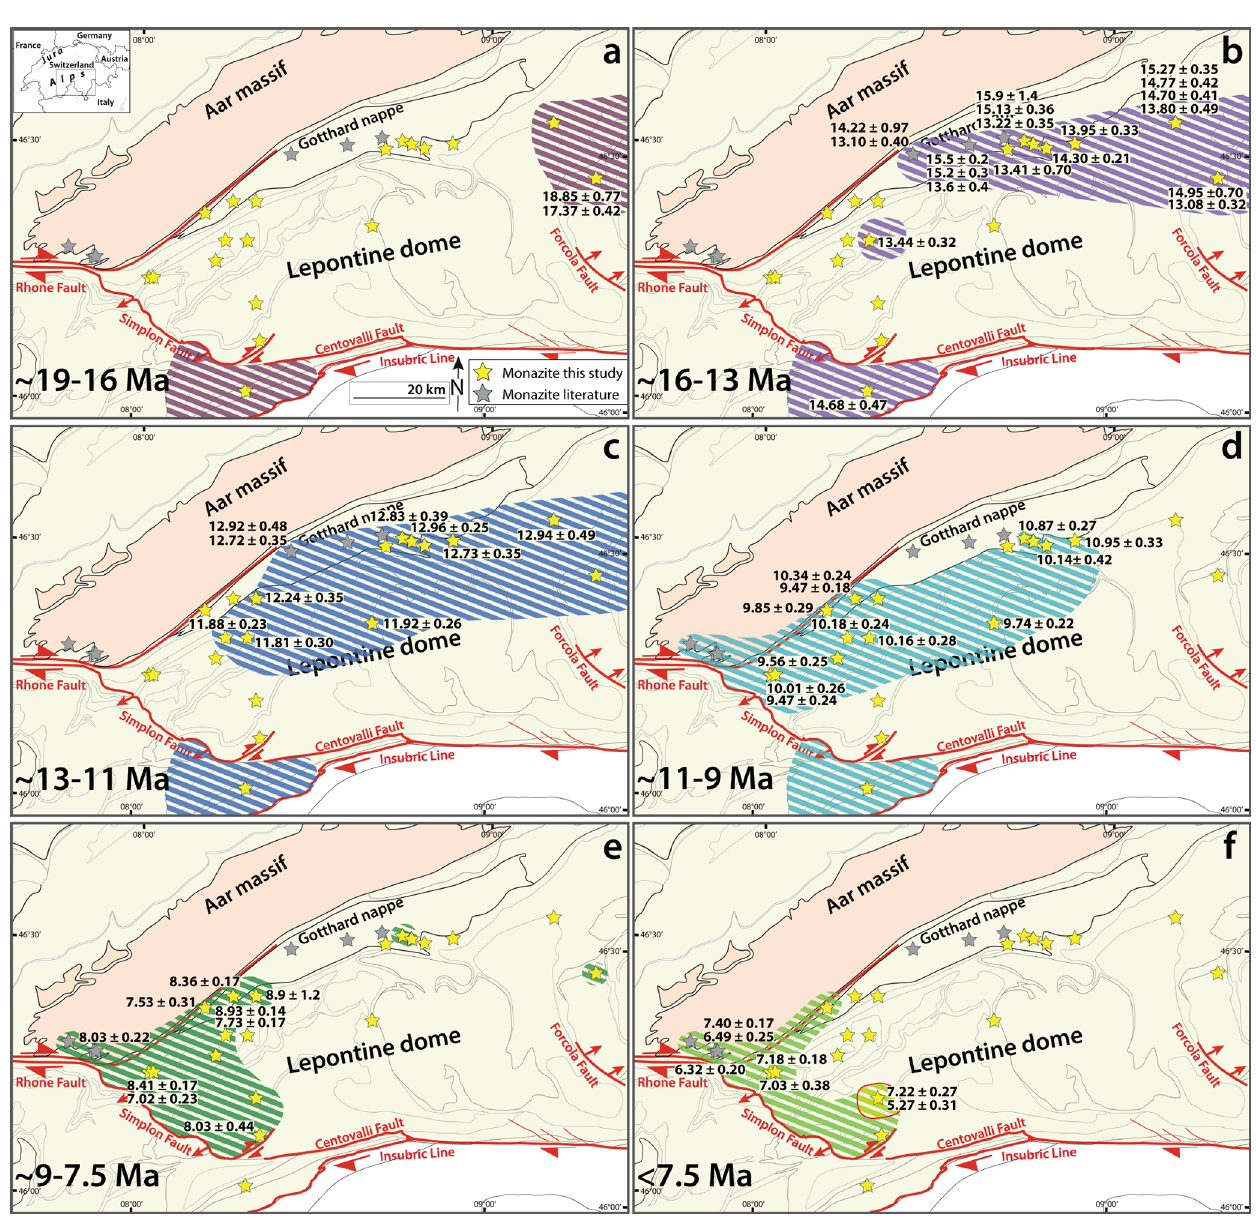
Figure 7. Overview maps of the study area modified from Steck et al. (2013) and Schmid et al. (2004) showing the relevant monazite-(Ce) spot and mean age record over time and space. Note the shift over time from the southern and eastern regions of the Lepontine Dome to the central and western areas and finally to the areas close to the shear zones bounding its western limit. Mean ages, quoted near the stars representing the corresponding sample locations, indicate individual tectonic events that could be identified for a grain. Ages are ordered into six time intervals. Published hydrothermal monazite-(Ce) locations (gray stars) of the areas adjacent to the Lepontine Dome are from Janots et al. (2012), Berger et al. (2013), and Ricchi et al. (2019).